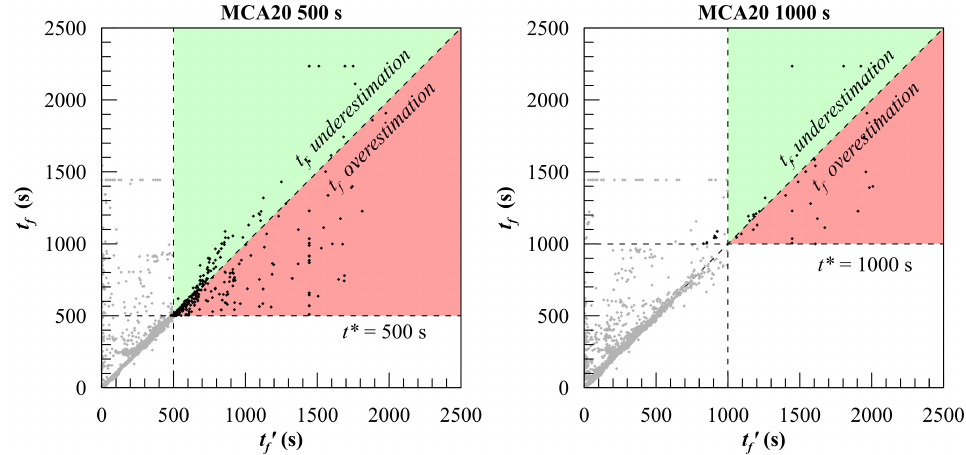
Figure 10. Predicted over observed values of the time-to-flood computed at t ∗ = 500 s and t ∗ = 1000 s. Training: MCA20; validation: MC50b; method: RFs.